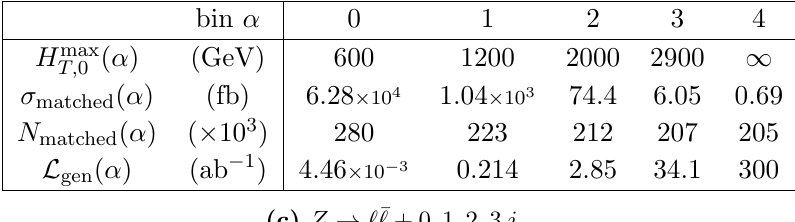
Table 2. The upper edge value of H T; the number of samples after matching, N matched , and the equivalent luminosity, L gen , in each H T; 0 bin for the Z -boson production